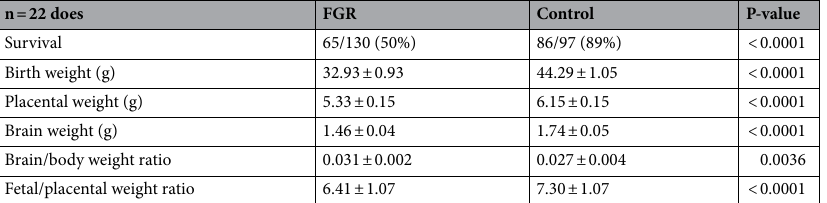
Fig. 2A. FGR kittens had abnormal posture, gait, and locomotion, but activity duration was similar to controls. Additionally, FGR led to hampered cranial nerves activity, pain response, and righting reflex.